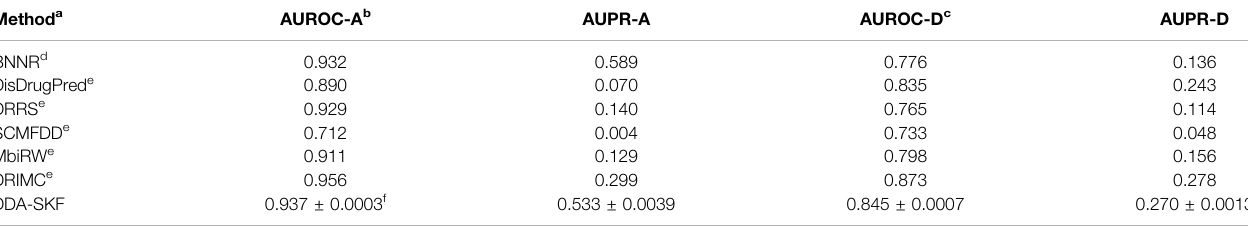
TABLE 1 | Performance comparison analysis using both the novel association test and novel drug